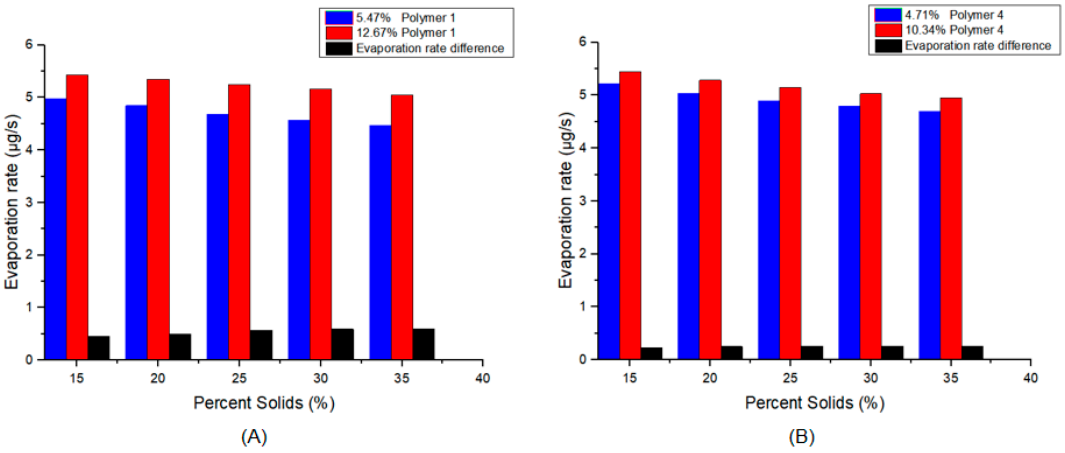
Figure 9. Evaporation rate of Polymer 1 ( A ) and Polymer 4 ( B ) solutions with different initial %solids concentrations.